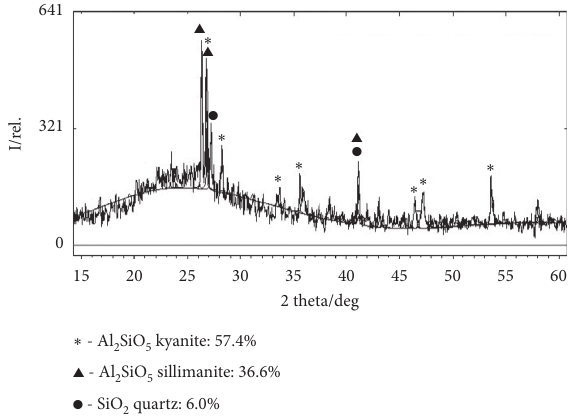
Figure 5: X-ray analysis of the composition of kyanite-sillimanite (7 mass units) and orthophosphoric acid (3 mass units), strengthened at 300 ° S